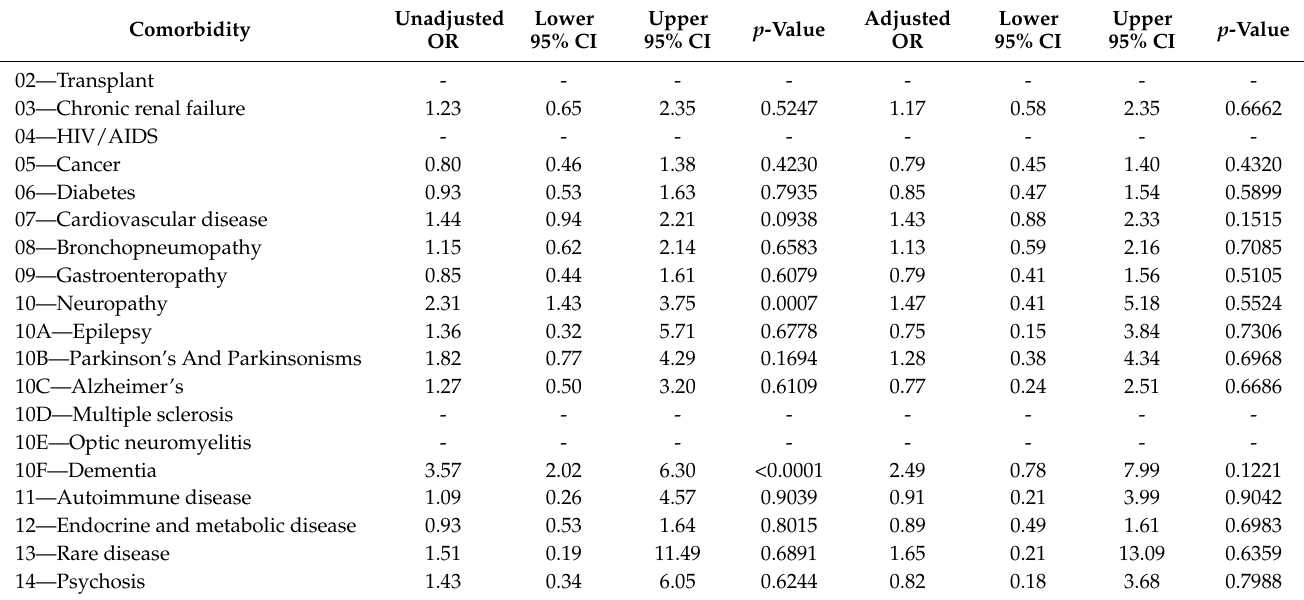
Table 5. Comorbidities implicated in dead reinfected SARS-CoV-2 patients from September 2021 to May